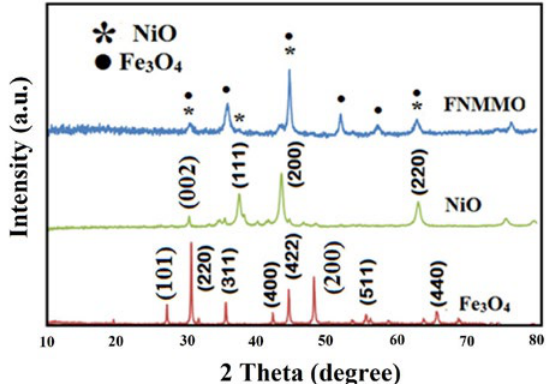
Fig. 3. XRD plots of Fe